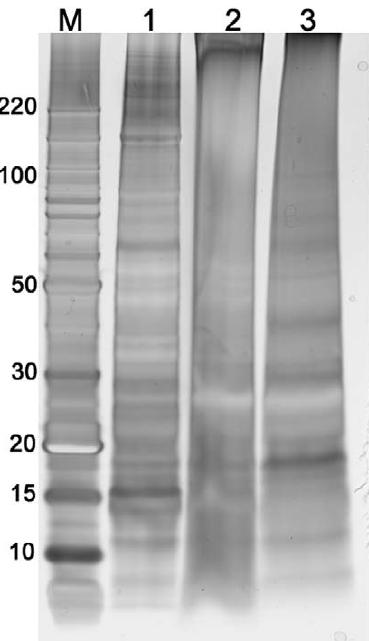
Figure 3. Elevated pressure improves protein extraction from FFPE mouse tissue. Eleven month old FFPE mouse liver tissue was heated in 50 mM Tris, pH 8 + 2% SDS at either elevated pressure (40,000 psi) or atmospheric pressure (14.7 psi). The electrophoretic mobility of 15 m g of Fresh and FFPE tissue extracts were compared by 1D-PAGE. Lane M: molecular weight marker; lane 1: fresh tissue extract; lane 2: FFPE tissue after retrieval at atmospheric pressure (14.7 psi); lane 3: FFPE tissue surrogate with after retrieval at 40,000 psi.